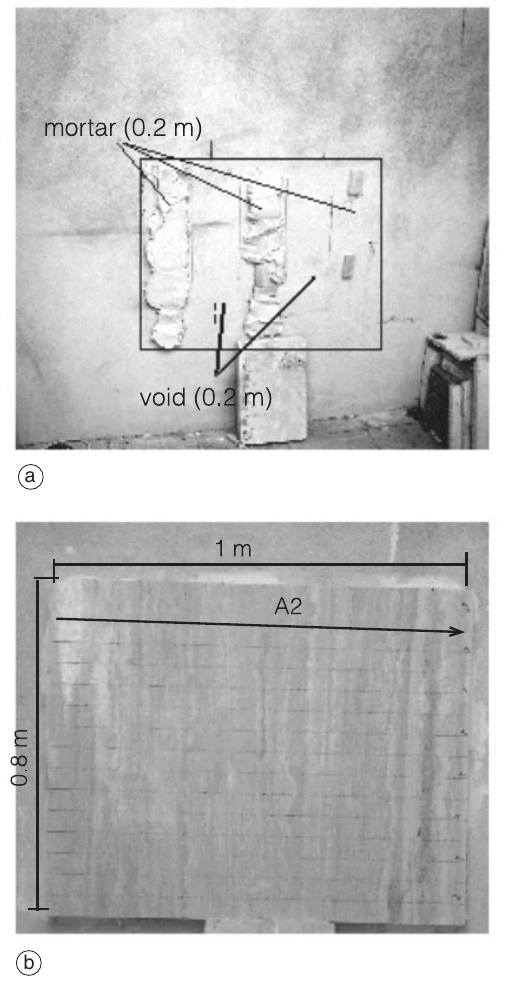
Fig. 3a,b. Photo of the travertine panel hung in the laboratory: a) before the assemblage on the wall with the position of mortar and void; b) hung on the wall with location of radar profile labelled